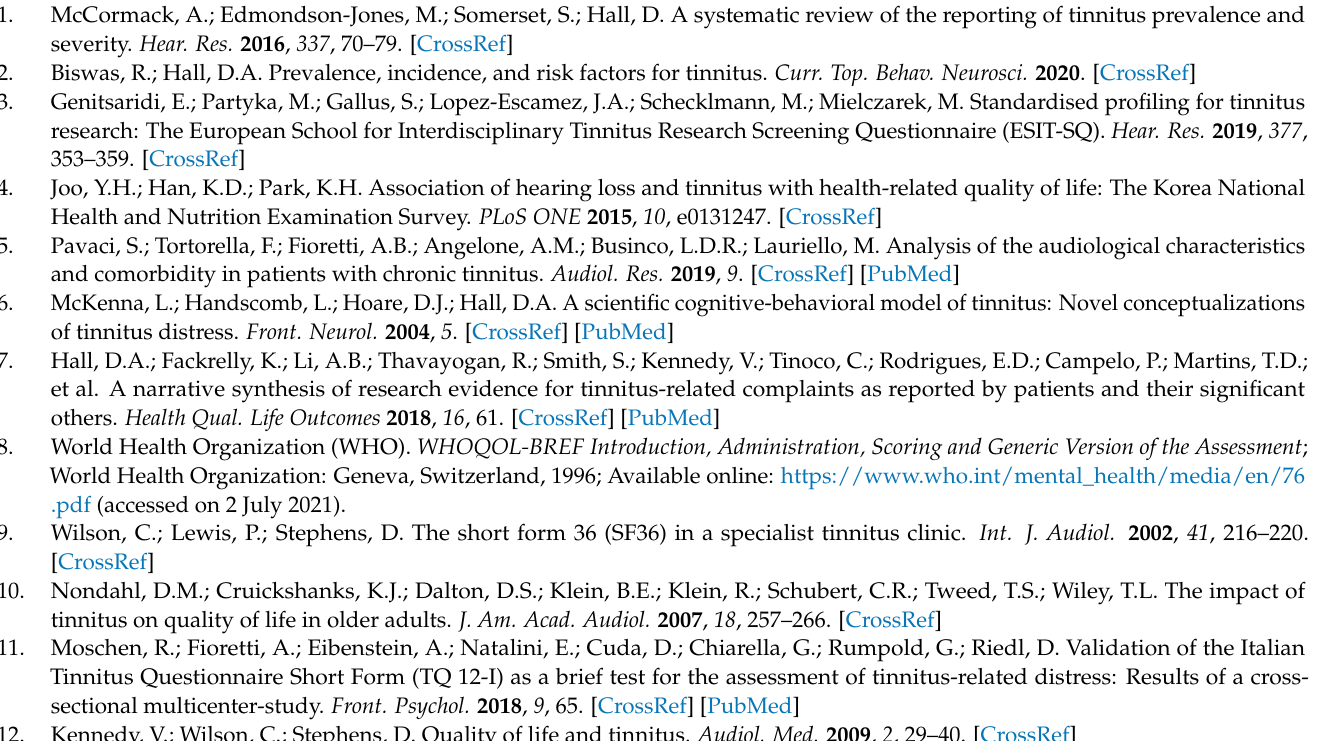
Figure S2: Average scores of the BSI questionnaire and correspondent 95% confidence interval bands for the three groups of Tinnitus